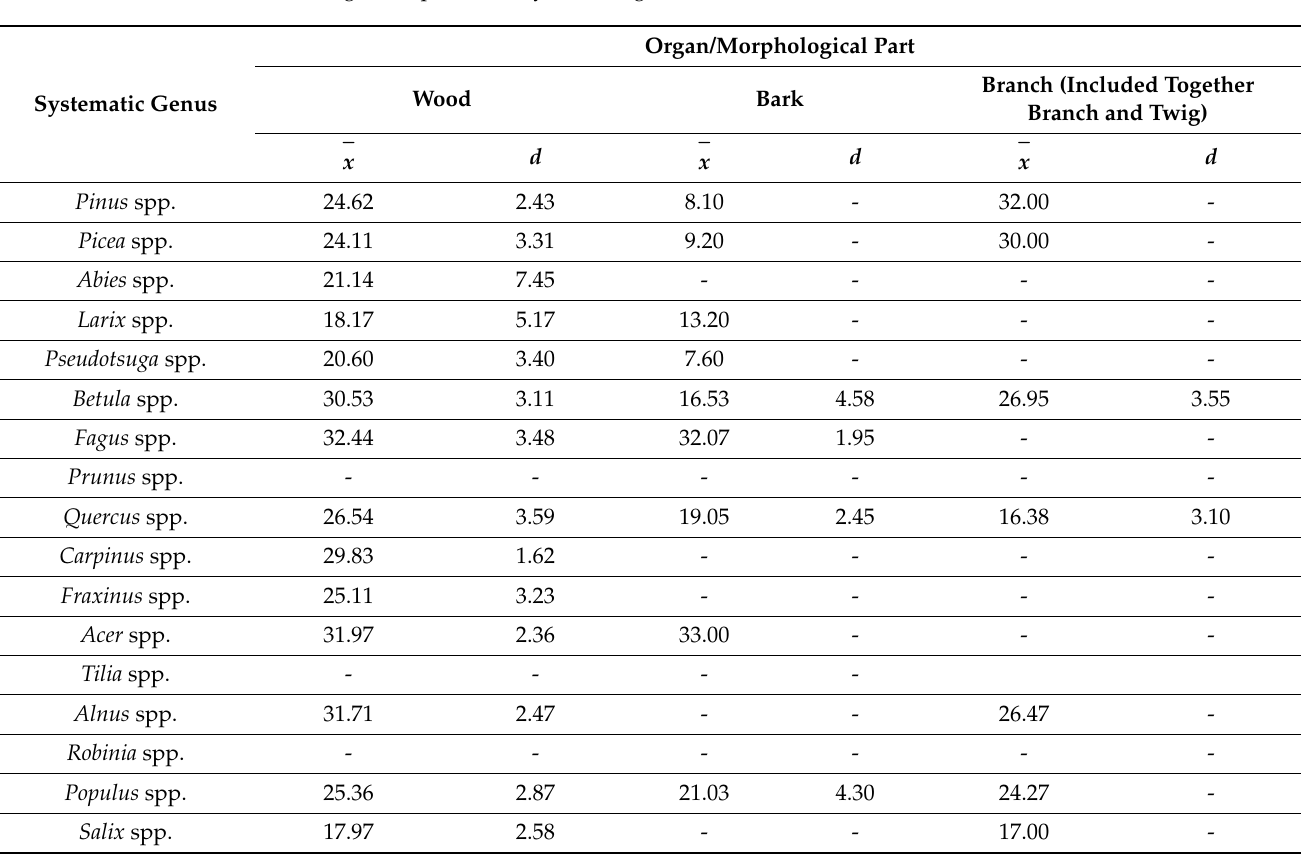
Table A22. Average value and average deviation of the hemicellulose content (% d.m.) in various organs of particular systematic genera